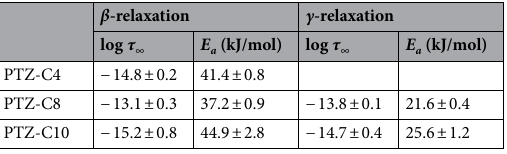
Table 2. The parameters obtained from the fitting of the τ β and τ γ data depicted in Fig. 7b to the Arrhenius